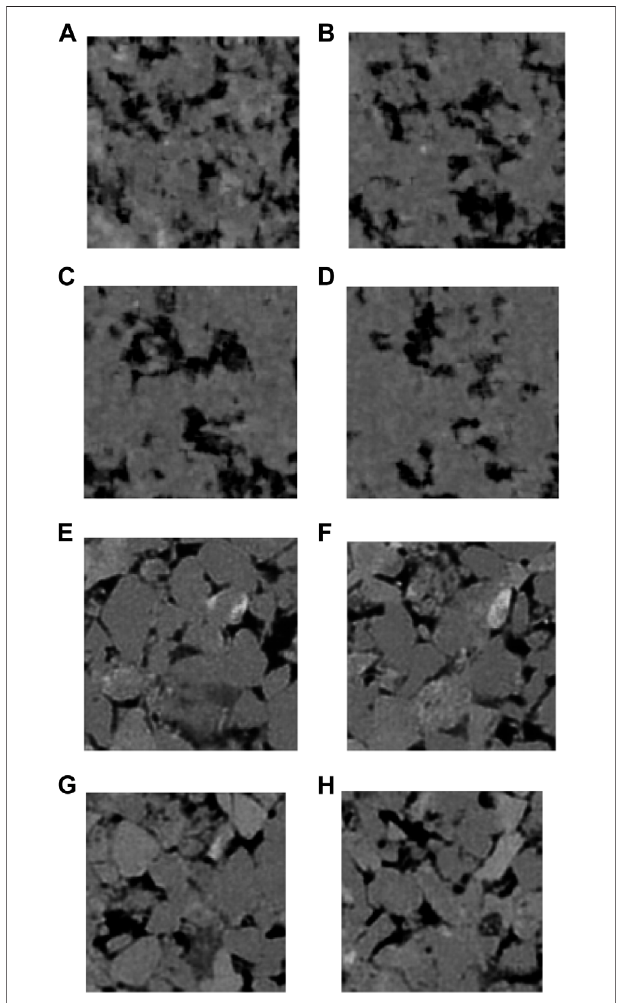
FIGURE 6 | Cross-sectional view of structure reconstructed by the SD algorithm (A – D) and the CPGAN algorithm (E – H) .